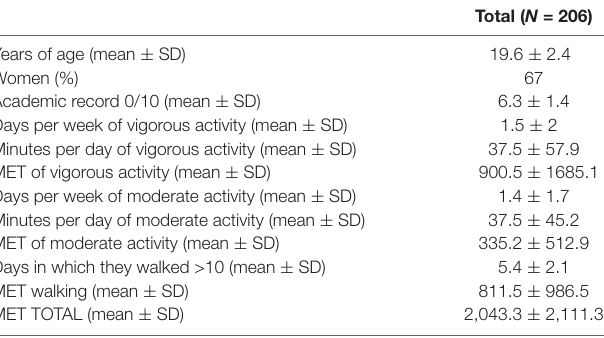
TABLE 1 | Sociodemographic characteristics and international physical activity questionnaire (IPAQ)